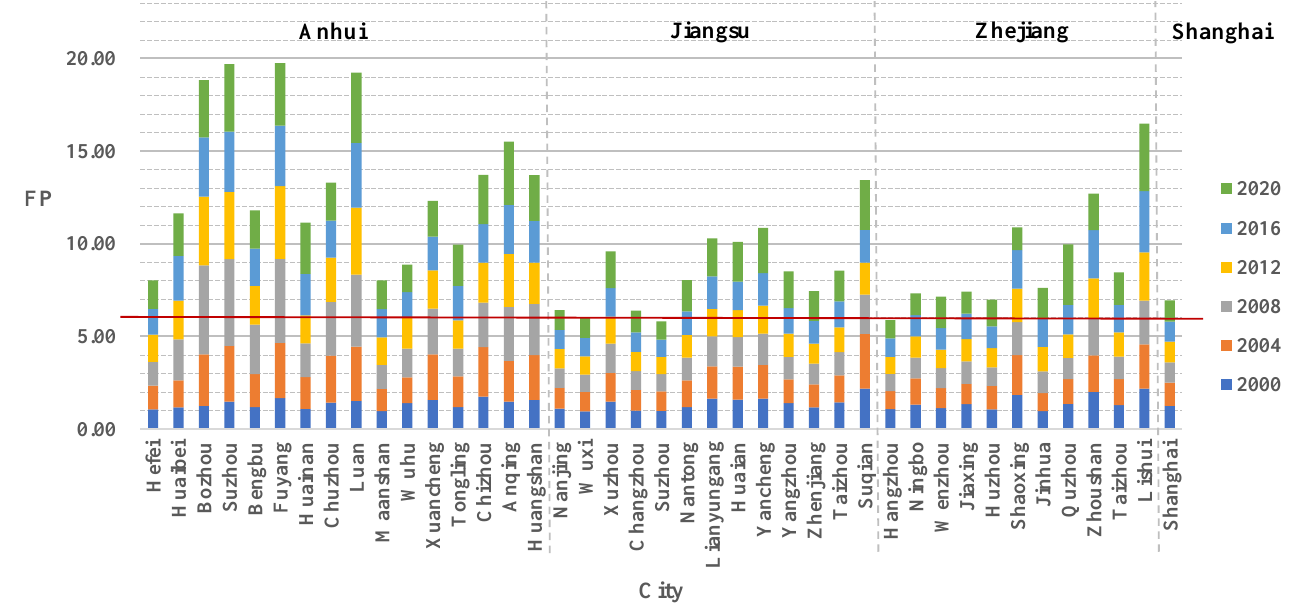
Figure 2. Changes in FP in the YRD region.